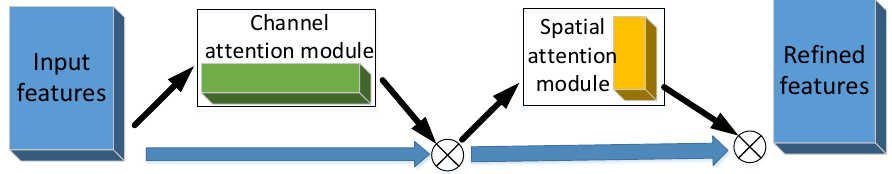
Figure 3. The structure of the CBAM attention mechanism.